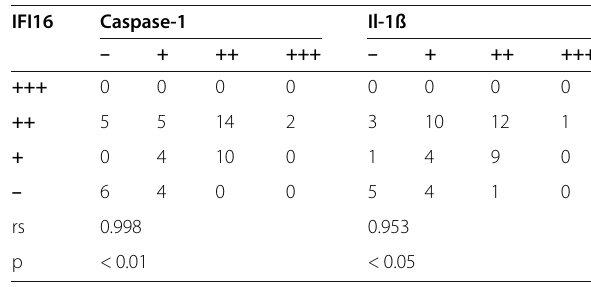
Table 4 Expression of IFI16 was no correlation between pathological types of HBV-GN